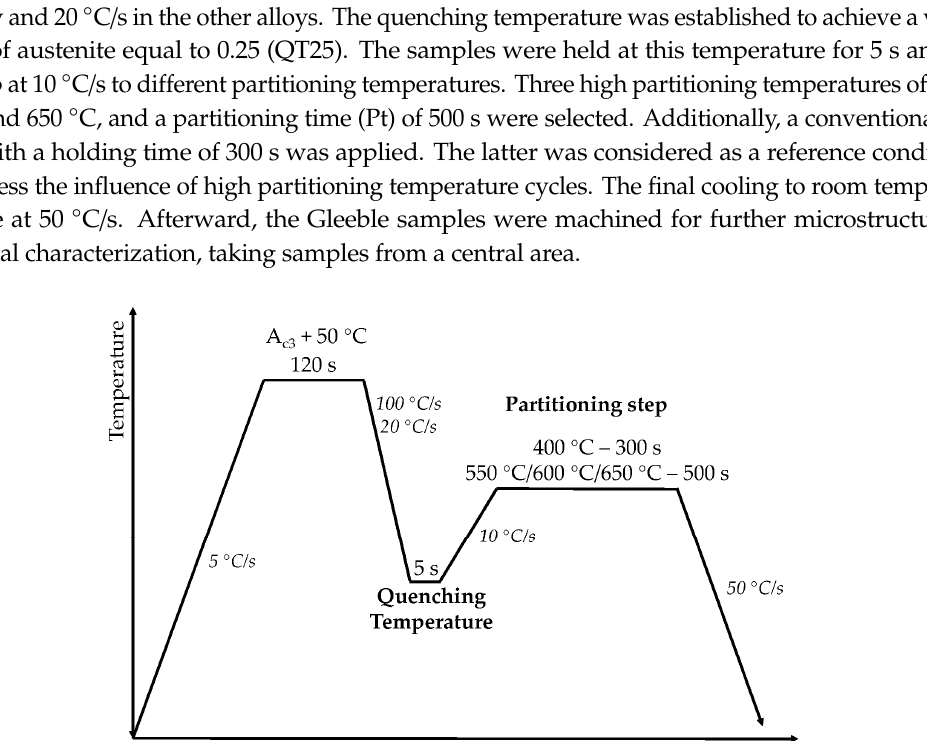
Table 1. Chemical composition of the steels (wt.%).